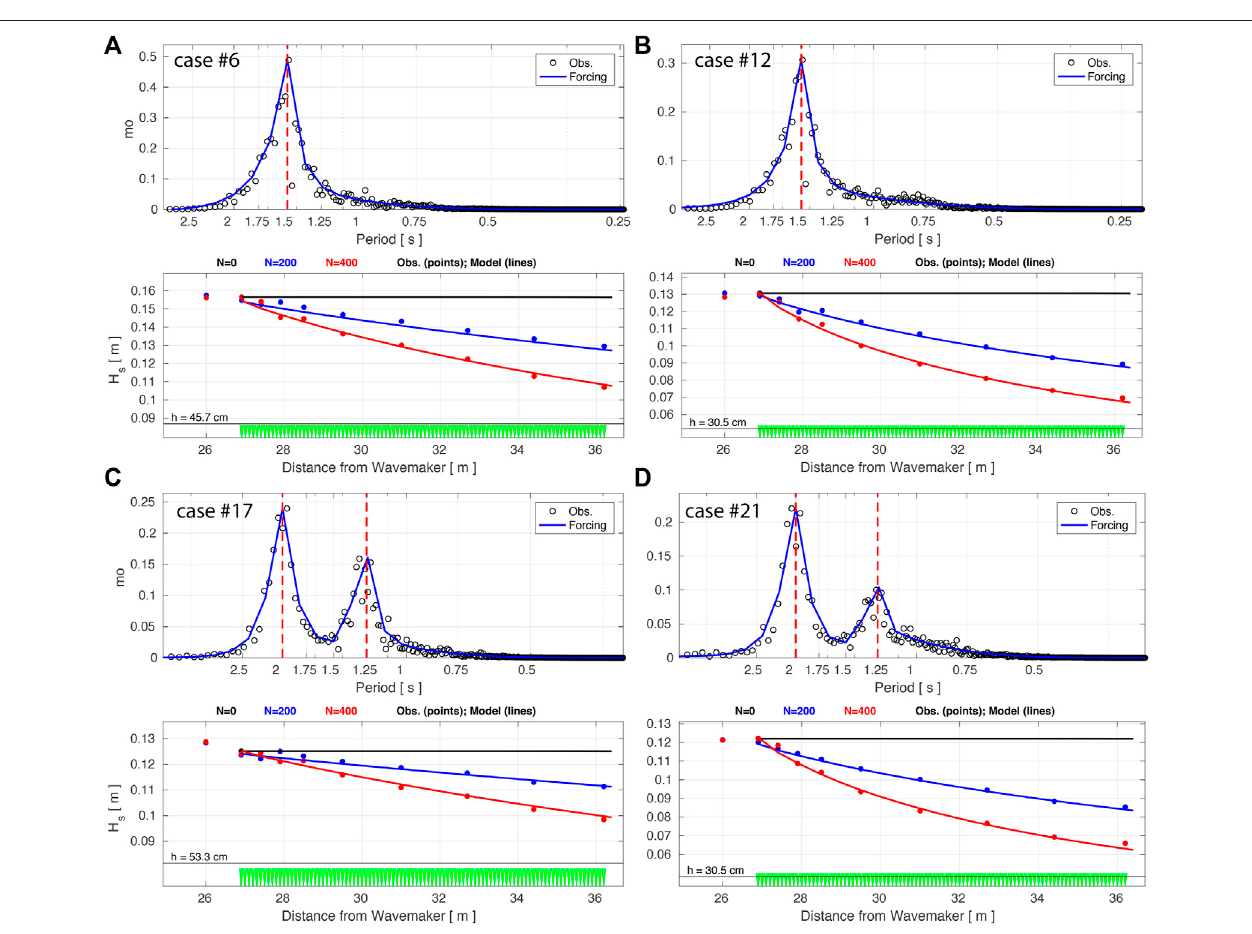
FIGURE3| Upper panels) Spectraldensity forsingle-peak (A,B) and double-peak (C,D) wavesat the5 th gaugeinthe fl ume(black circles) and boundaryforcingin the WW3 model (solid blue). The dashed red lines show the peak(s). (Lower panels) Signi fi cant wave height observed in the lab (circles) and from the WW3 model (solid) for no vegetation (black), N =200 stems/m 2 (blue) and N =400 stems/m 2 (black). Wave conditions for Cases 6 (A) , 12 (B) , 17 (C) , and 21 (D) are provided in Table 1 .